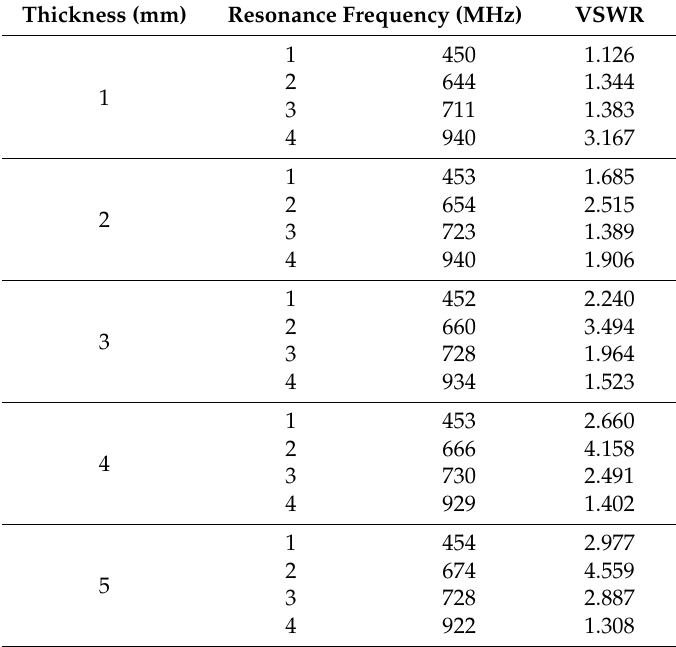
Table 2. Resonance points and their VSWR under different dielectric layer thickness.